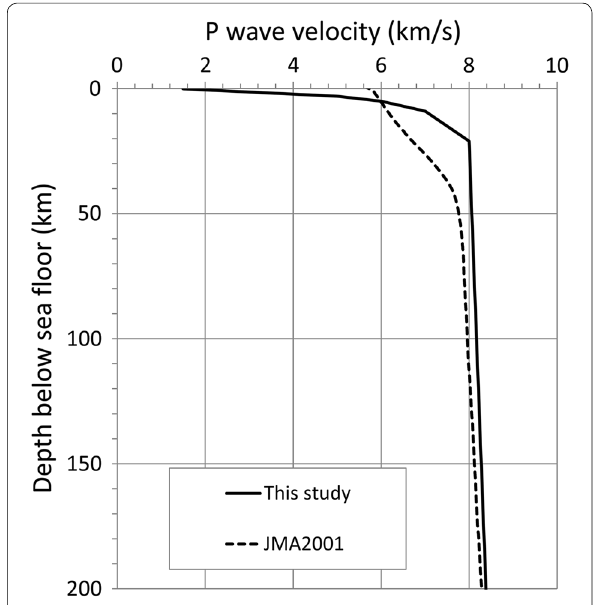
Fig. 3 One-dimensional P-wave velocity model used for hypocenter determination derived from Takahashi et al. (2009). For comparison, the velocity model used by JMA2001 (Ueno et al. 2002) is also